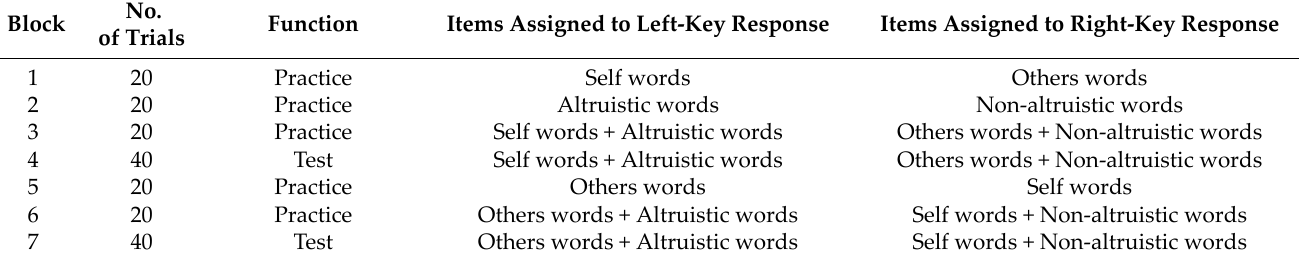
Table 1. Seven blocks of IAT procedure.